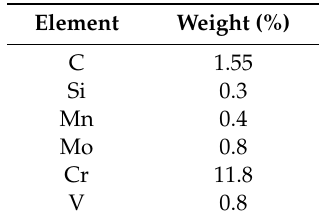
Table 1. AISI D2 tool steel chemical composition.